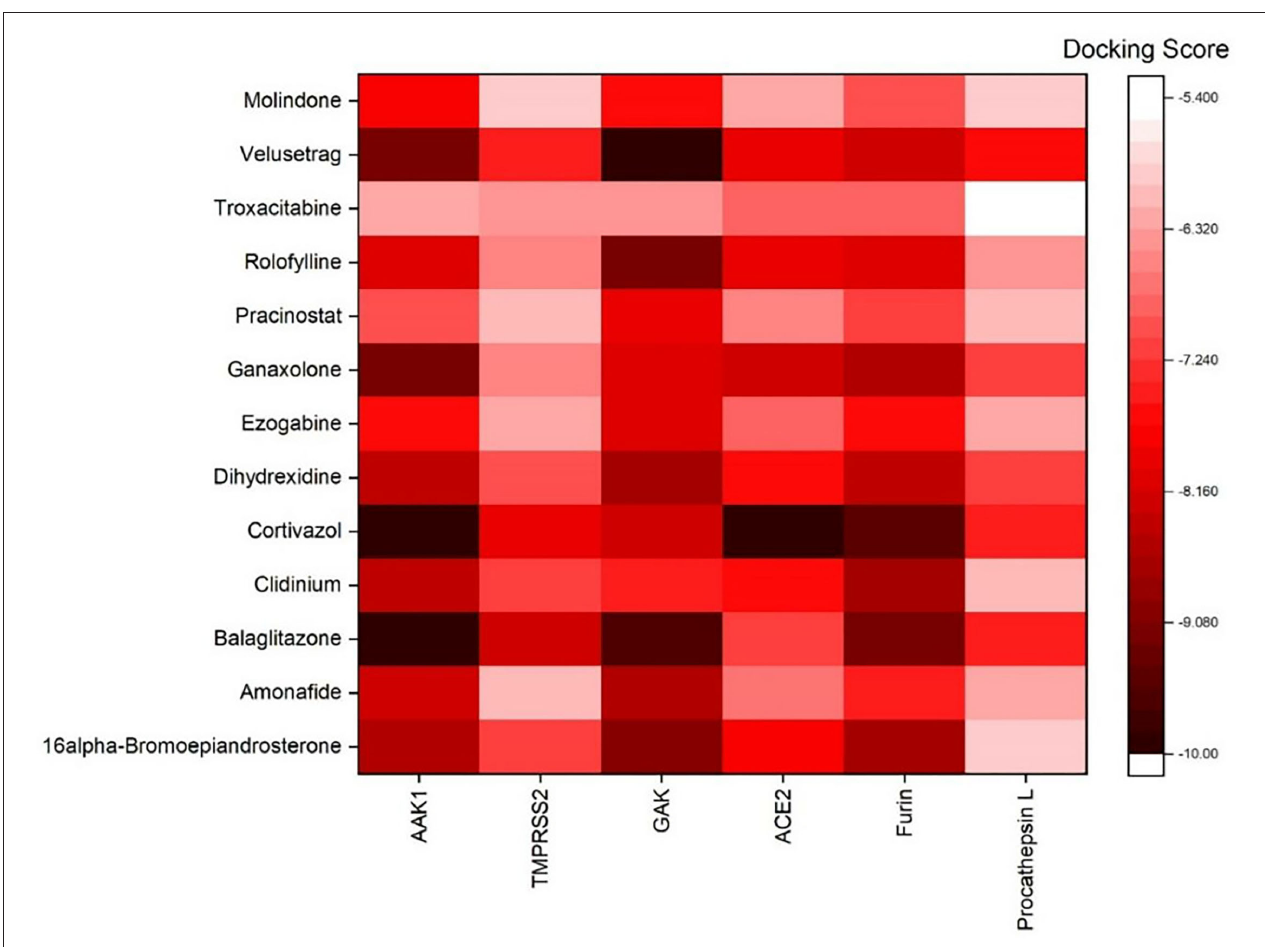
FIGURE 4 | Binding affinity or docking scores of the predicted repurposed drugs against six COVID-19 host proteins. The candidate predicted drugs are mentioned along the y-axis whereas the host COVID-19 protein targets are mentioned along the x-axis. The Docking score bar is showing the maximum to the minimum value, where the dark red color presents the maximum score of 10 and the white fed color shows 5.4. The highest binding affinities of 9.0 to 10.0 kcal/mol were − − − achieved for Velusetrag-GAK, Cortivazol-ACE2, Balaglitazone-AAK, and Cortivazol-ACE2 complexes.